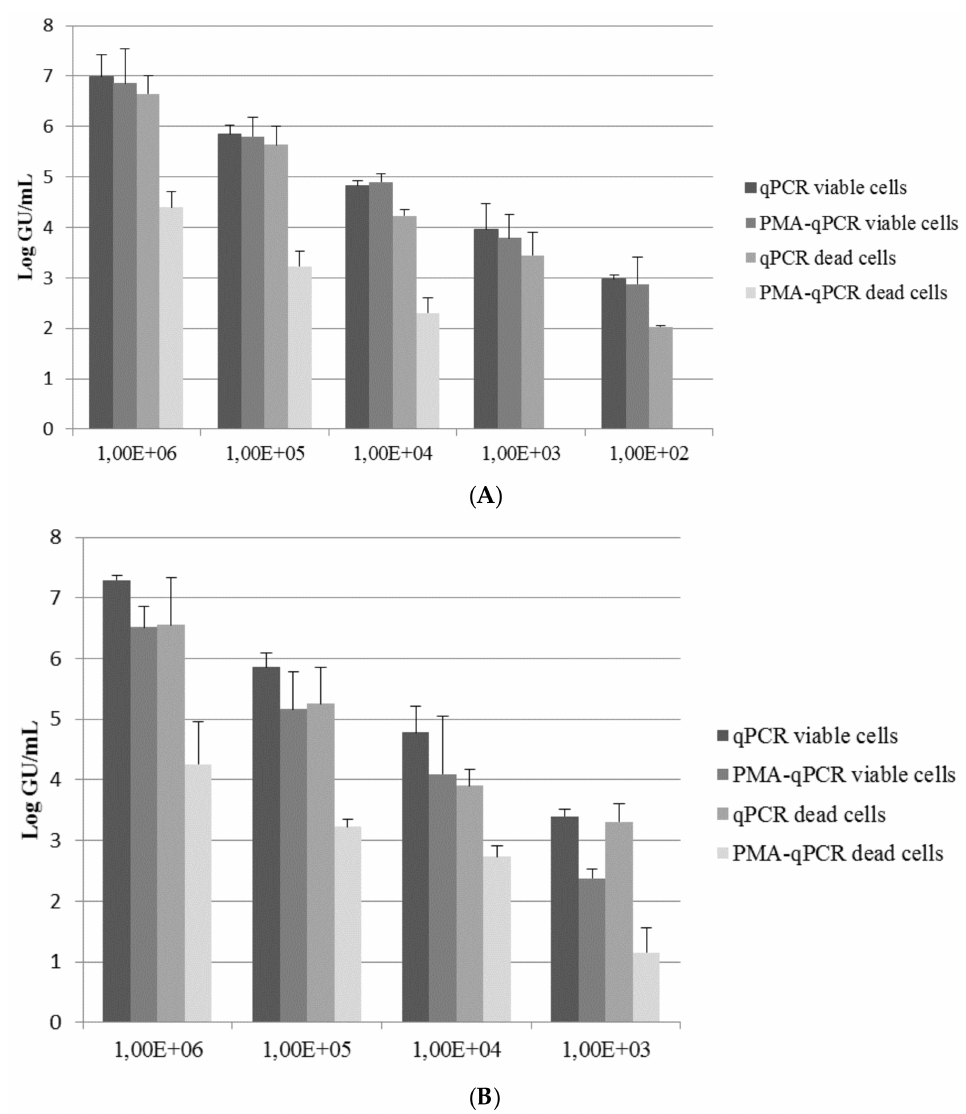
Figure 2. Quantification of the dilution ranges (10 2 –10 6 colony-forming units (CFU)/mL) for viable and heat-killed L. pneumophila by quantitative polymerase chain reaction (qPCR) and PMA-qPCR. Each pillar represents the mean value obtained in three independent experiments for each bacterial concentration. The error bar represents standard deviations of the mean from three independent experiments. ( A ) Exposure Protocol A, on filter; ( B ) Exposure Protocol B, in